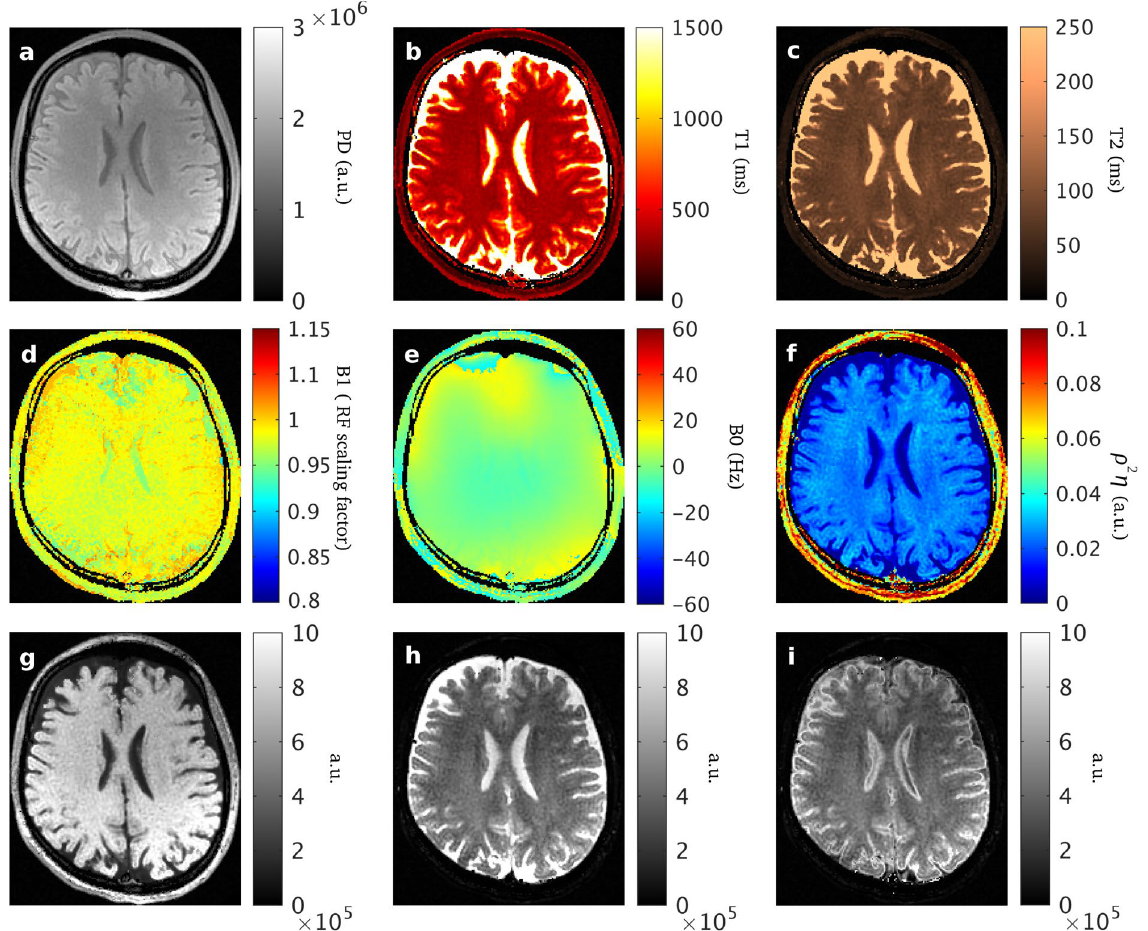
Figure 8. The parametric maps derived with the proposed model are shown estimated from the MP-b-nSSFP sequence with α = 30º, γ = 175º, TR = 30 ms. Top row shows: (a) PD (proton density, a.u.); (b) T 1 (ms); (c) T 2 (ms); (d) B + 1 (excitation RF field scaling factor); (e) B 0 (deviation in static magnetic field; Hz); (f) ρ 2 η = det ( A ) = ε 2 2 ε 1 ( HO harmonic oscillator), (g) synthetic T 1 -weighted; (h) synthetic T 2 -weighted; (i) synthetic T 2